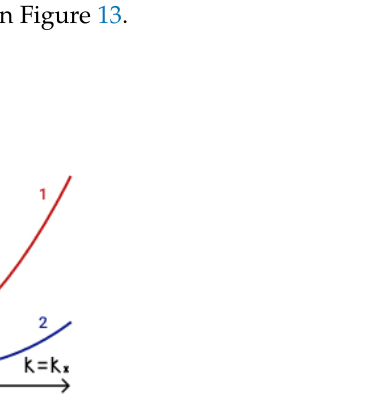
) + ω mgr ( k x ) ; ( b ) two magneto-Rossby waves and one c c ) + ω ( k x ) . mr 1 c c